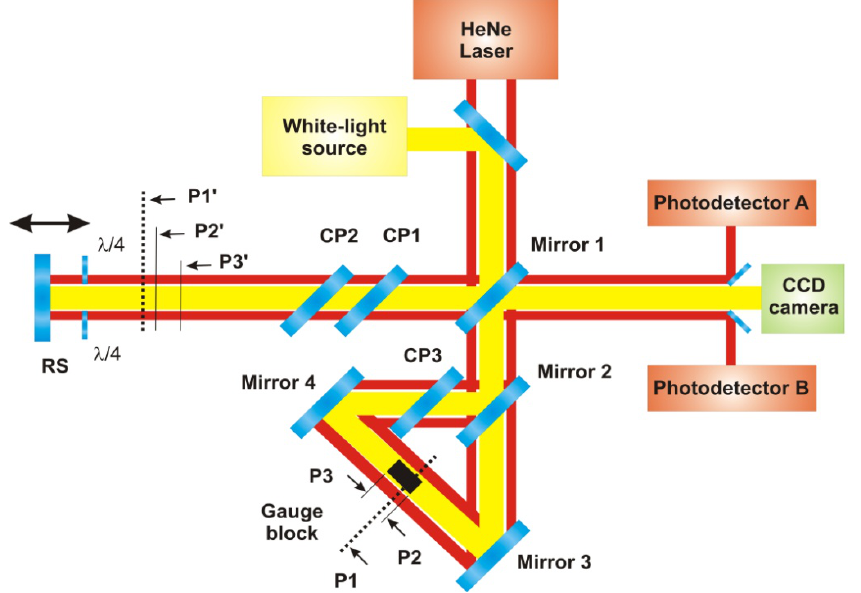
Figure 1. Optical setup for gauge blocks measurement. CP1, CP2 and CP3